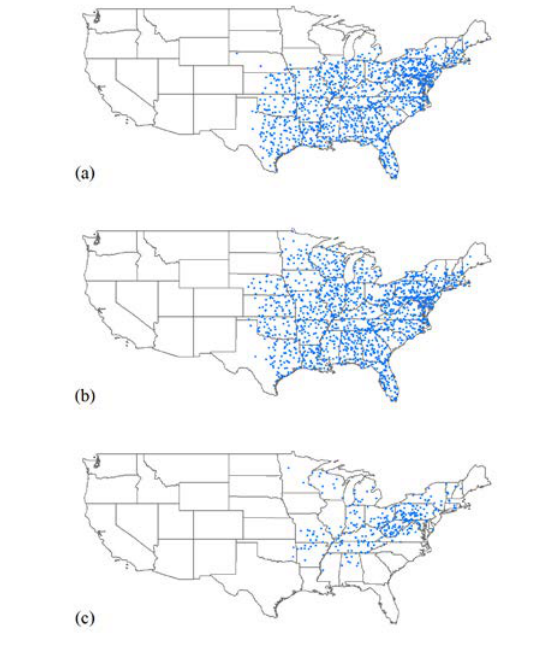
Figure 2. Illustrations of the 0.5° rasterized maps showing the spatial distributions of the climatic factors (2014) for (a) PRE, (b) VAP, and (c)